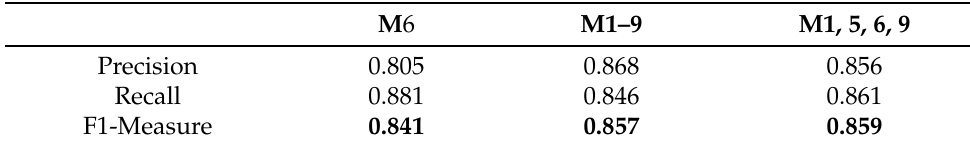
Table 7. Analysis of results.F1-Measure that is most suitable for overall accuracy evaluation has been bolded.